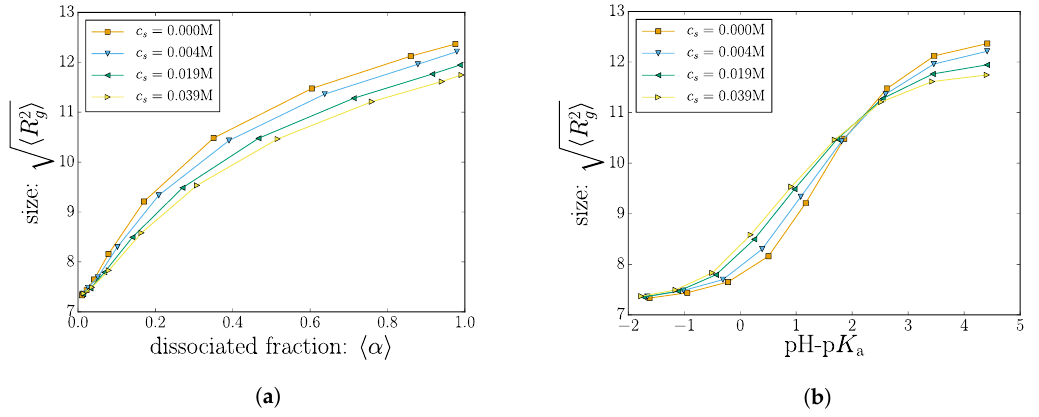
Figure 4. (Color online) ( a ) The radius of gyration is plotted as a function of the mean degree of dissociation; ( b ) the radius of gyration is plotted as a function of pH-p K a . The different markers indicate different salt